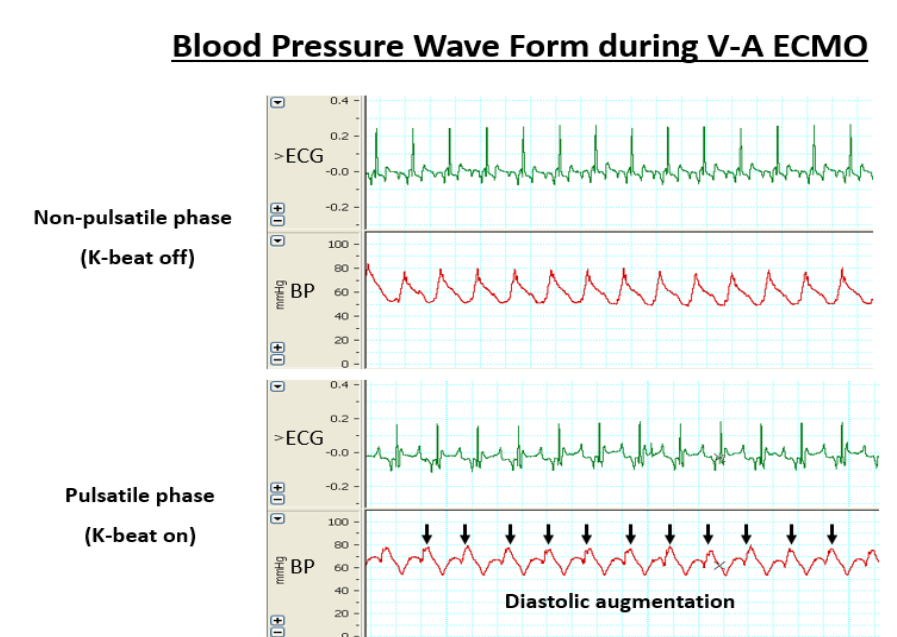
Figure 2. Blood pressure waveform during V-A ECMO. Upper: Non-pulsatile phase (K-beat on). Lower: Pulsatile phase (K-beat off). Black arrow indicates increased diastolic pressure.